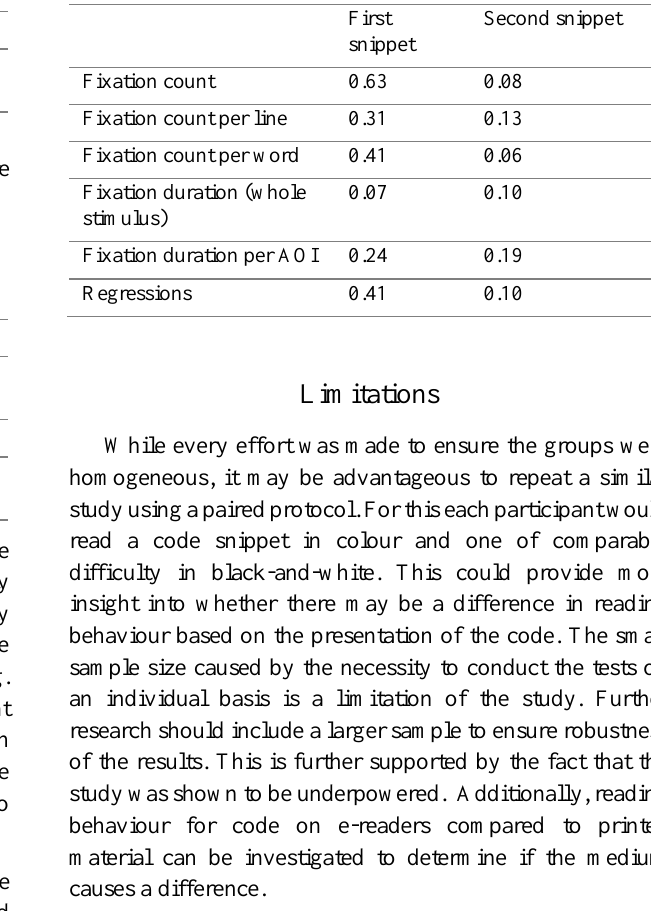
Power analysis results for all metrics and both code